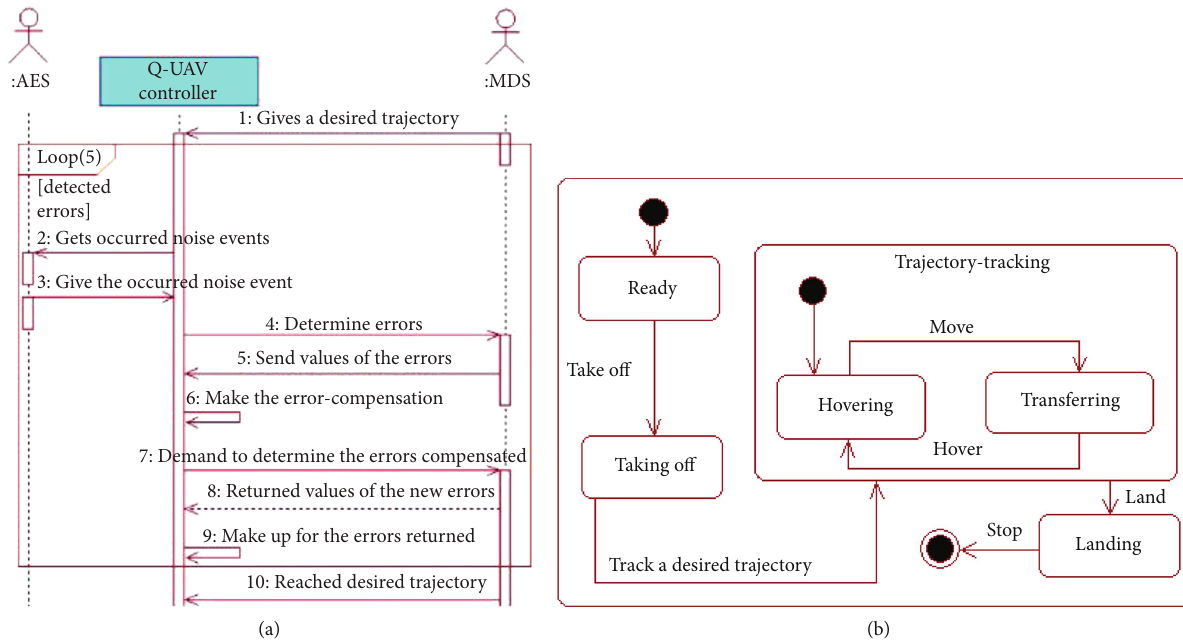
Figure 4: A desired trajectory-tracking scenario (a) and local state machine for performing the “ Track a desired trajectory ” use case (b).